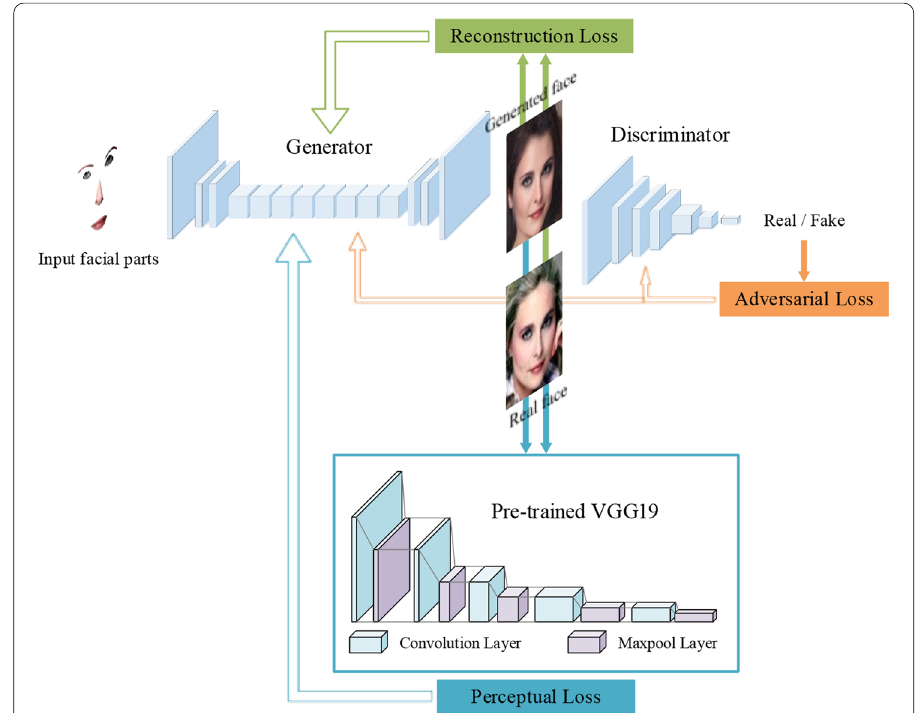
Fig. 2 Network architecture. In the architecture, the extracted human facial parts are input into the generator to generate a fake face. The discriminator is used to discriminate between real and generated faces. Reconstruction loss and perceptual loss are obtained by comparing generated faces and real faces. The reconstruction loss part is shown in green and is used to train the generator. The perceptual loss part is represented in dark blue, and its calculation uses a pretrained VGG19 network. Finally, the orange part represents the adversarial loss used to train the generator and